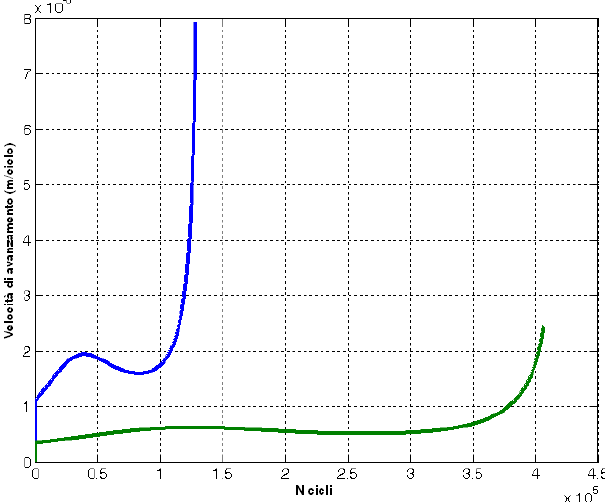
Figura 9: Velocità di avanzamento; in blu ed in verde le curve relative alla (1) e alla (2)